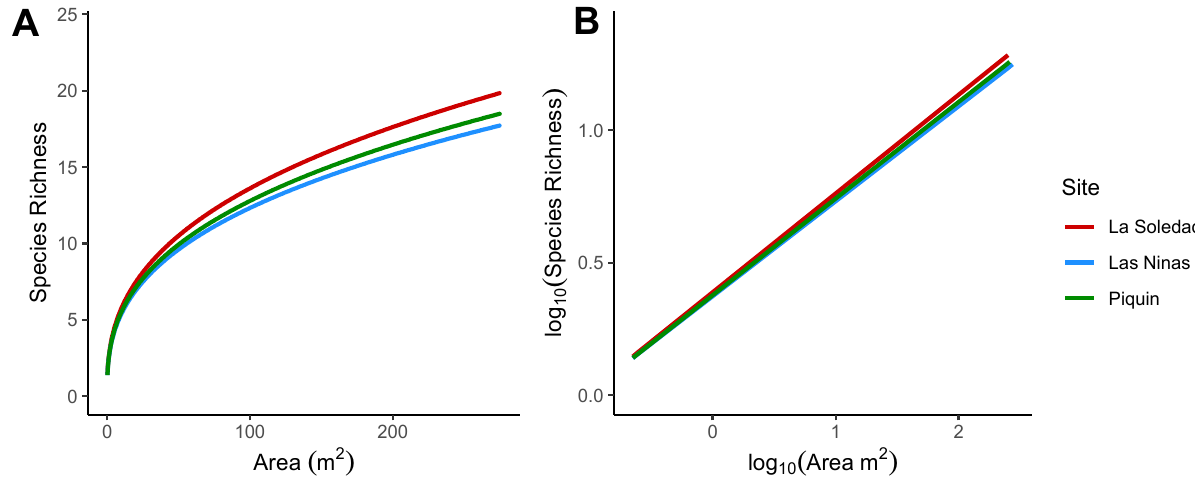
Figure 4. Representation of the power species-area curves for the woody patch vegetation within the olive groves. A, power species-area relationships on the raw scale; B, relationship between log-transformed species richness and log-transformed area at all three groves, described by a linear regression ANCOVA model interacting area with site. There is good model fit and significant effect of area (Linear regression, R 2 adj.=0.81, F=129.8, df=5.148, p<0.001) but no significant effect of site (‘Las Niñas’=-0.012, t=-0.322, p<0.001; ‘Piquín’=-0.011, t=-0.235, p<0.001) or interaction between site and area.